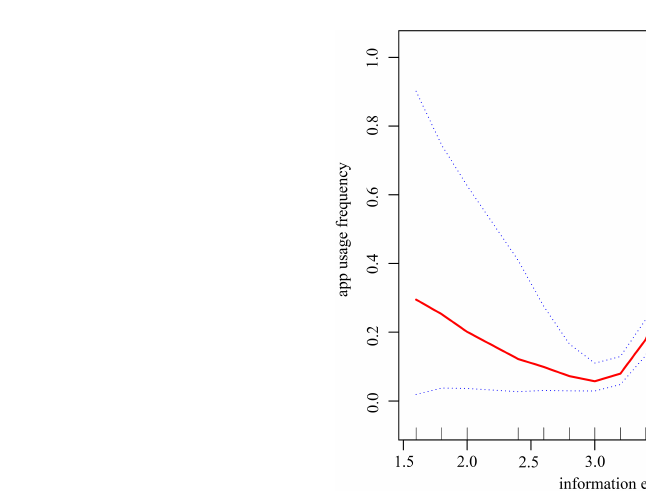
interaction tests were signi fi cant in different strata of the subgroups of medical insurance(p=0.0190), cohabitation with parents (p=0.0048), glycosylated hemoglobin (p=0.0076) and SMBG (p=0.0269).